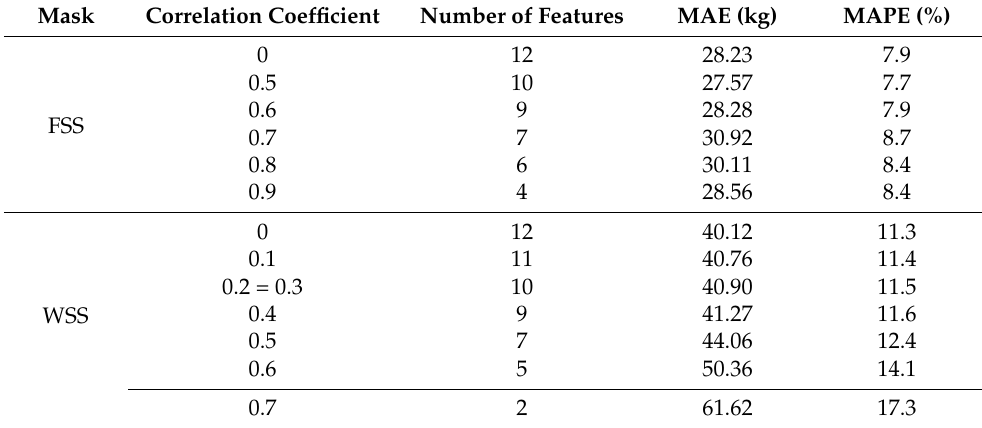
Table 6. Performance of RBF kernel-based SVR according to the correlation coefficient interval.